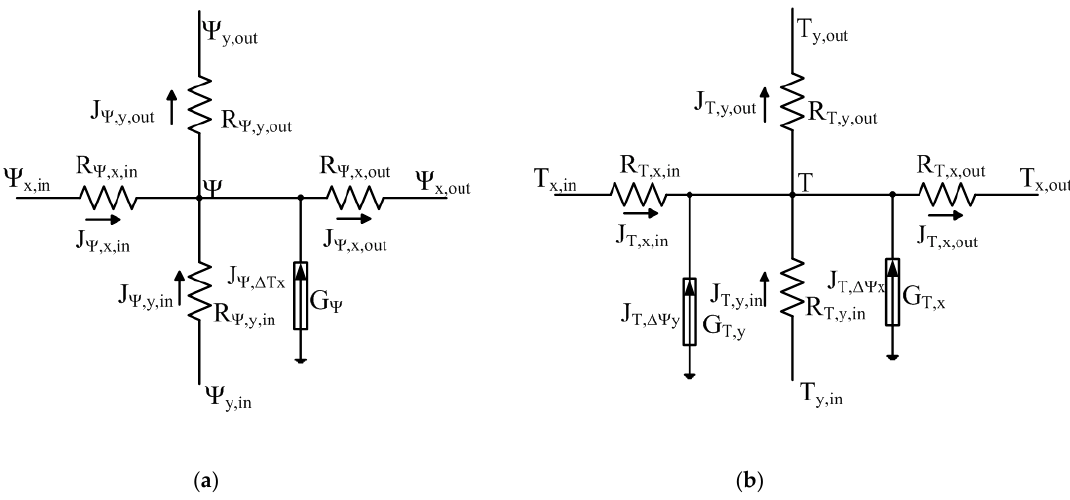
Figure 2. Nomenclature and network model: ( a ) streamfunction variable; and ( b ) temperature.